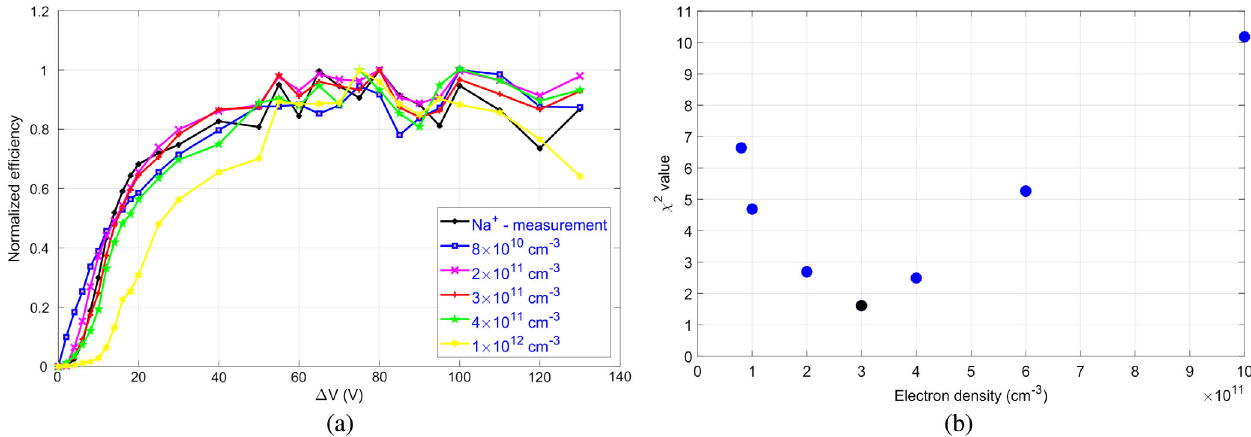
FIG. 7. (a) Comparison of simulated and experimental Na 1 þ Δ V curves acquired from n sweep. The minimum χ 2 value (optimum value of n